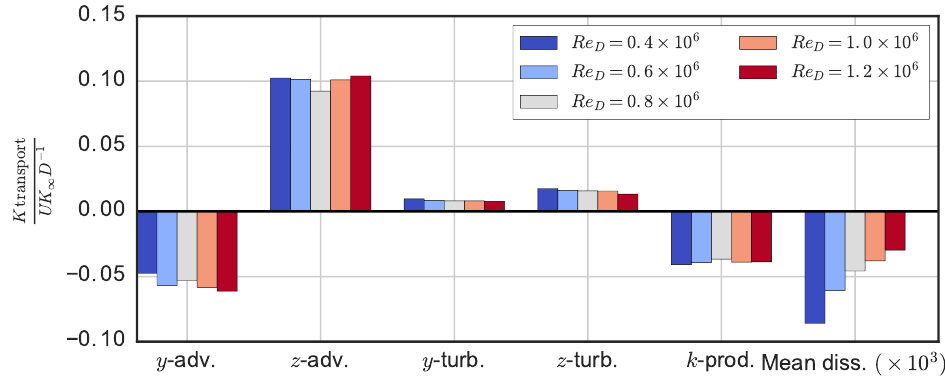
Figure 15. Normalized mean kinetic energy transport quantities computed as weighted averages based on Equation (9), omitting the non-measured streamwise derivatives. Note that directions of the turbulent transport terms refer to the directions of their partial